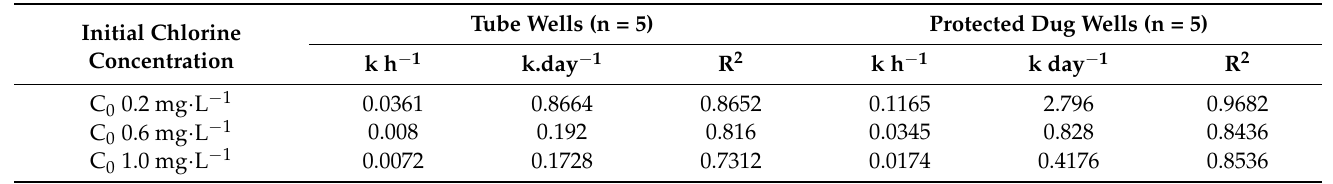
k, kinetic decay coefficients; R 2 , coefficient of